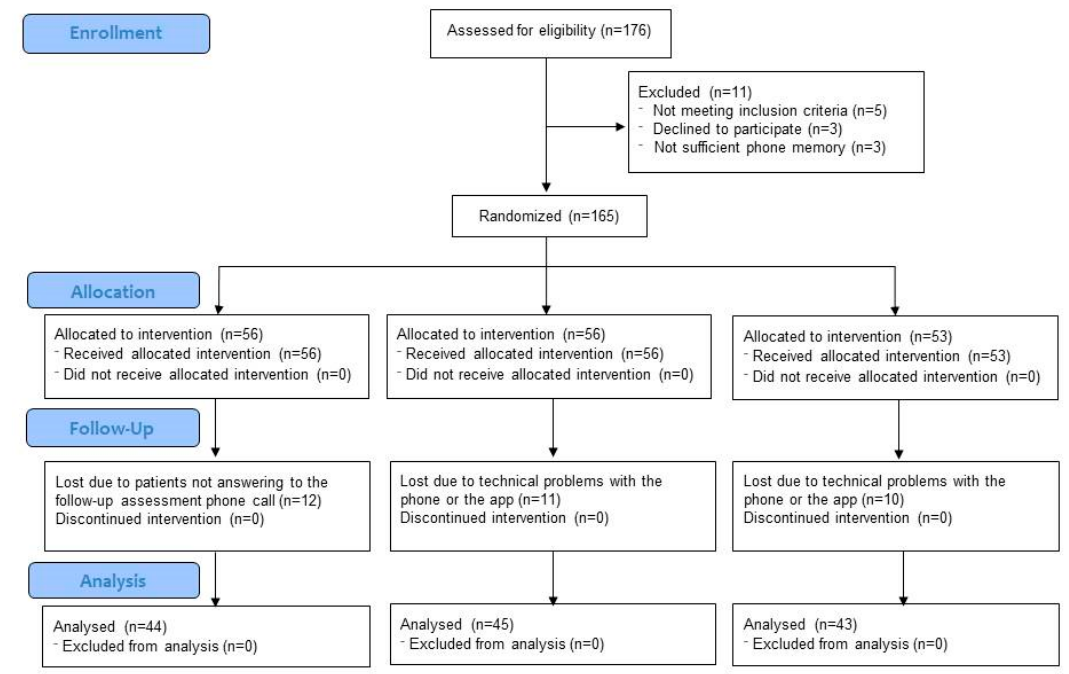
Figure 1. Study flowchart.